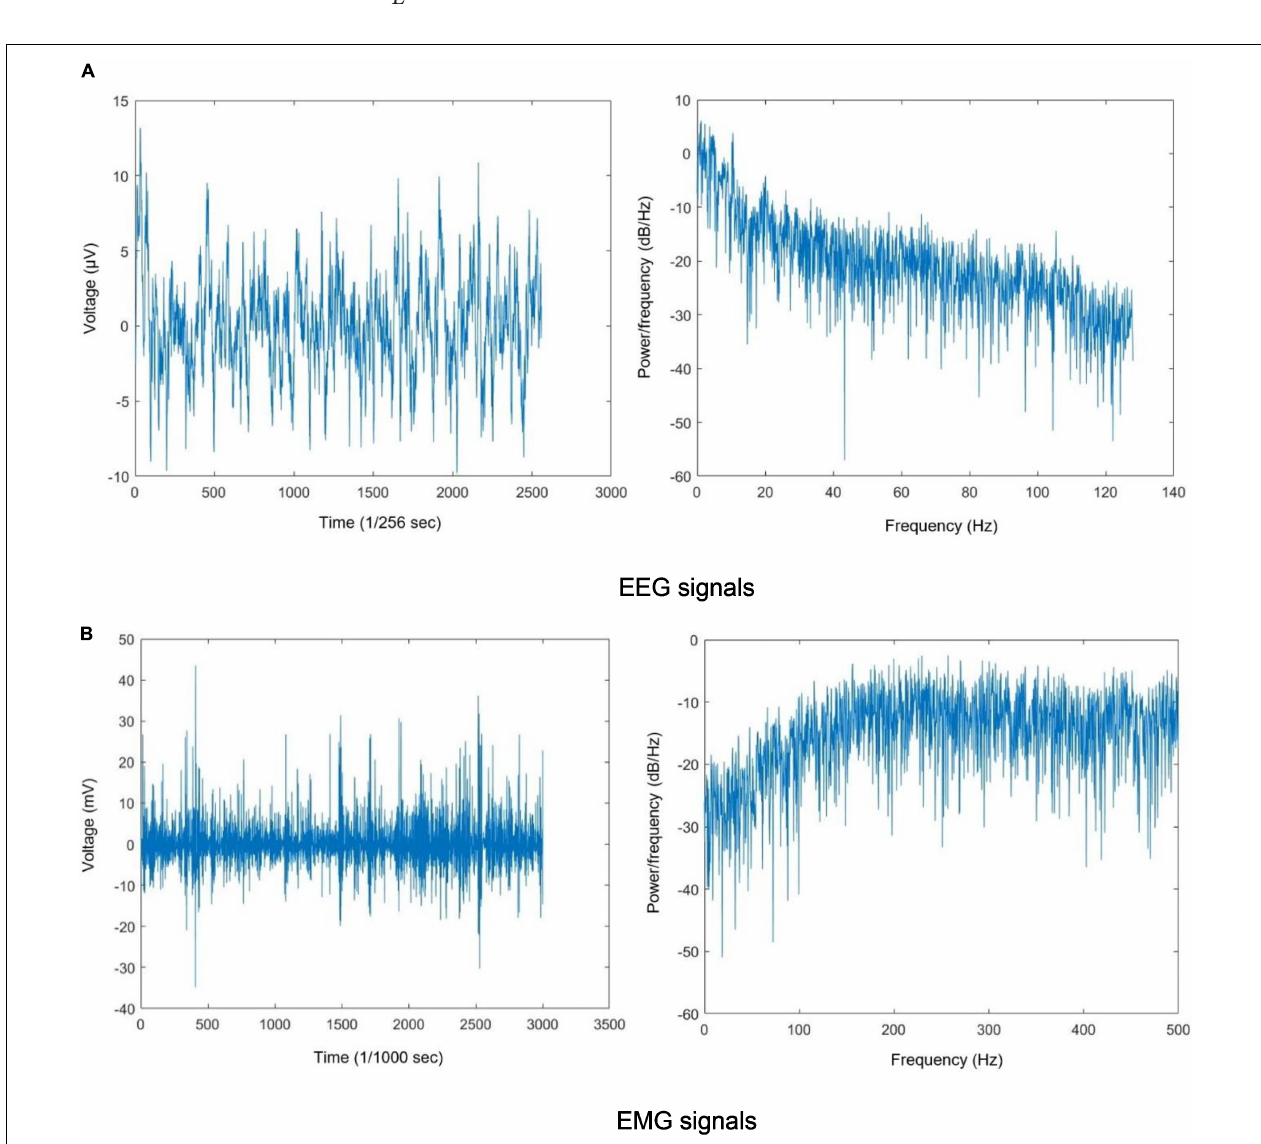
FIGURE 2 | (A) EEG signals and (B) EMG signals. The filtered EEG and EMG signals and their periodogram PSD